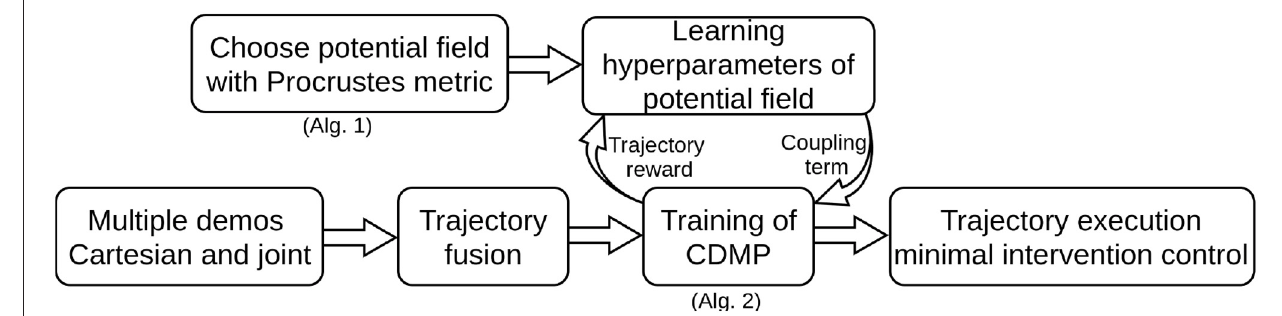
FIGURE 2 | Flowchart for illustration of the proposed algorithmic